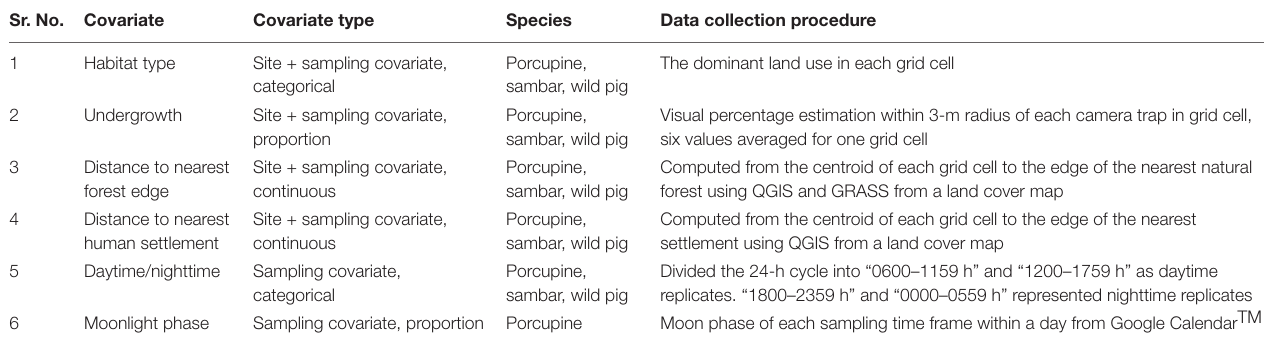
TABLE 1 | Covariates used to model habitat use of porcupine, sambar, and wild pig in Tillari region from January to April 2016. Sr. No.